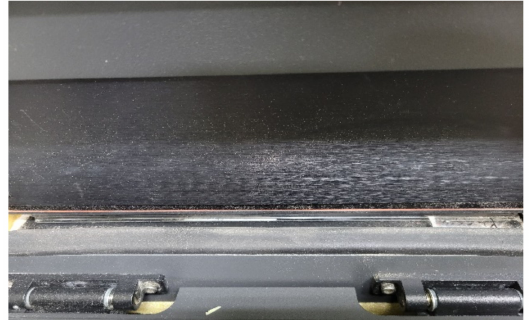
Figure 7. Thermal conductivity